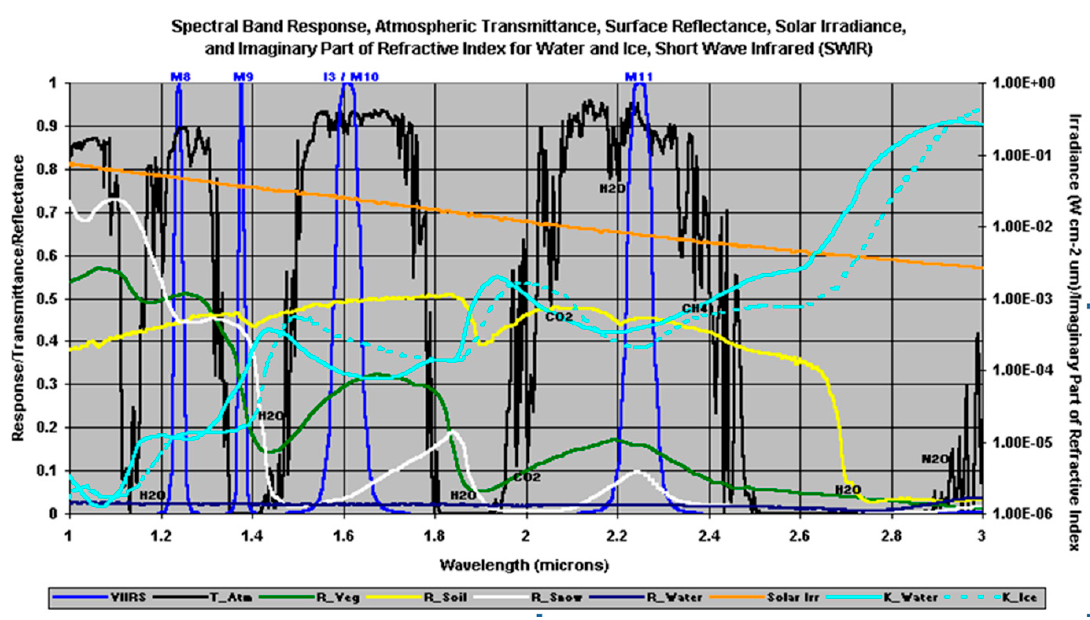
Figure 2. VIIRS bands and bandpasses, atmospheric transmittances, surface reflectances, and the absorptive parts of the indices of refraction for ice/water across the 1000–3000 nm range [11].